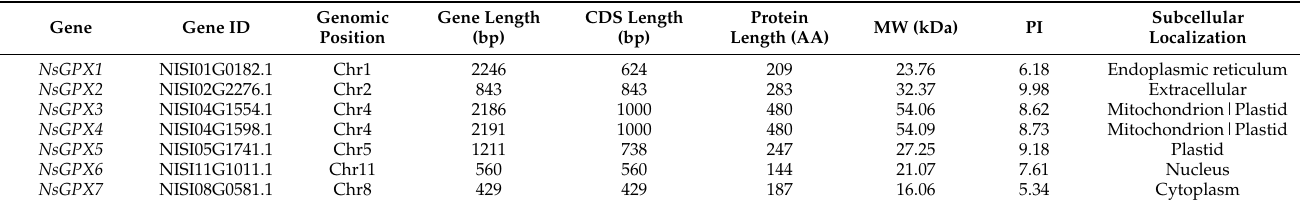
Table 1. The seven members of the NsGPX gene family identified from the N. sibirica